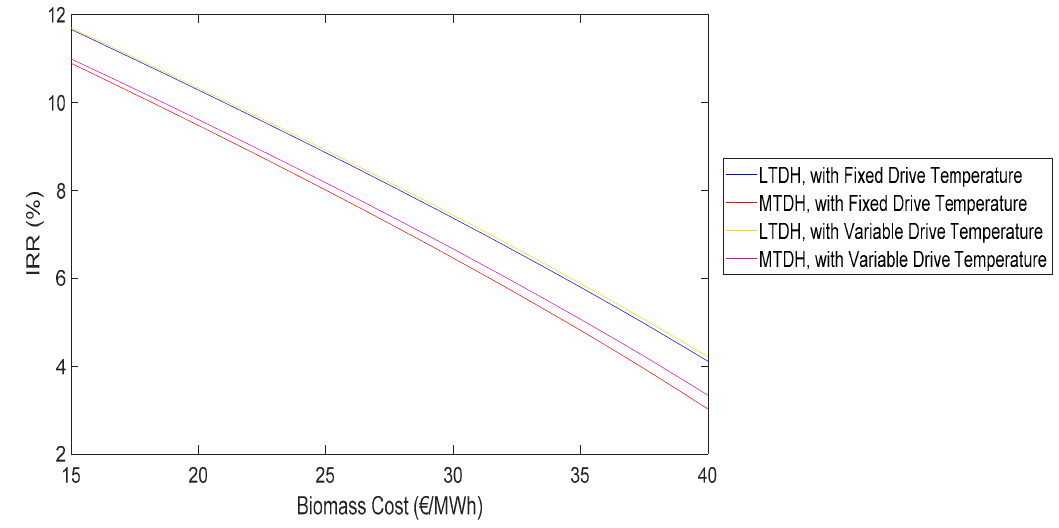
Figure 11. Influence of the cost of biomass on DH viability with different operation strategies.